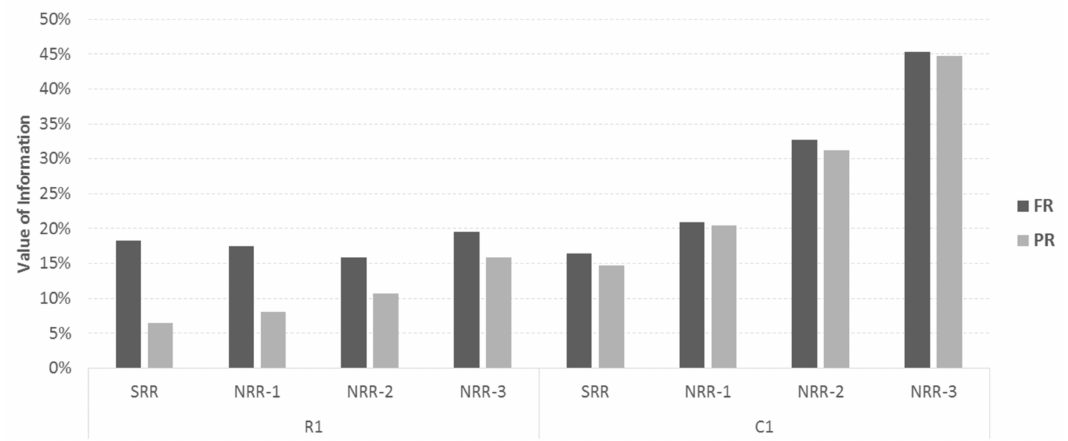
Figure 5. Average performance of re-optimization strategies for the di ff erent datasets (SRR—single-request re-optimization; NRR—N-request re-optimization; R1—customers have a uniform geographical distribution; C1—customers are